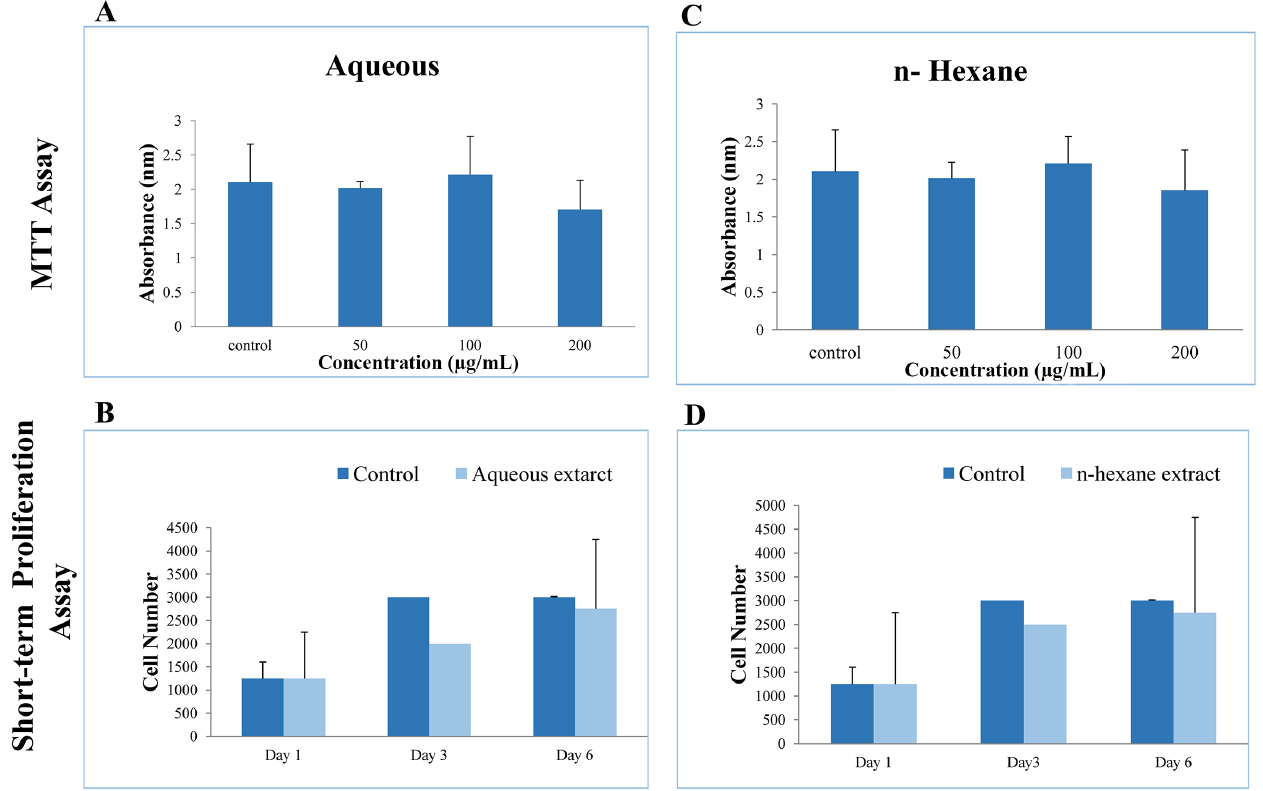
FIGURE 2 - Cytotoxic and Proliferative effects of Aqueous and n-hexane Extracts of Leaves of Acacia modesta Wall using HepG2 cell line. A) MTT assay of aqueous extract, B) Short-term proliferation assay of aqueous extract, C) MTT assay of n -hexane extract, D) Short term proliferation assay of n-hexane